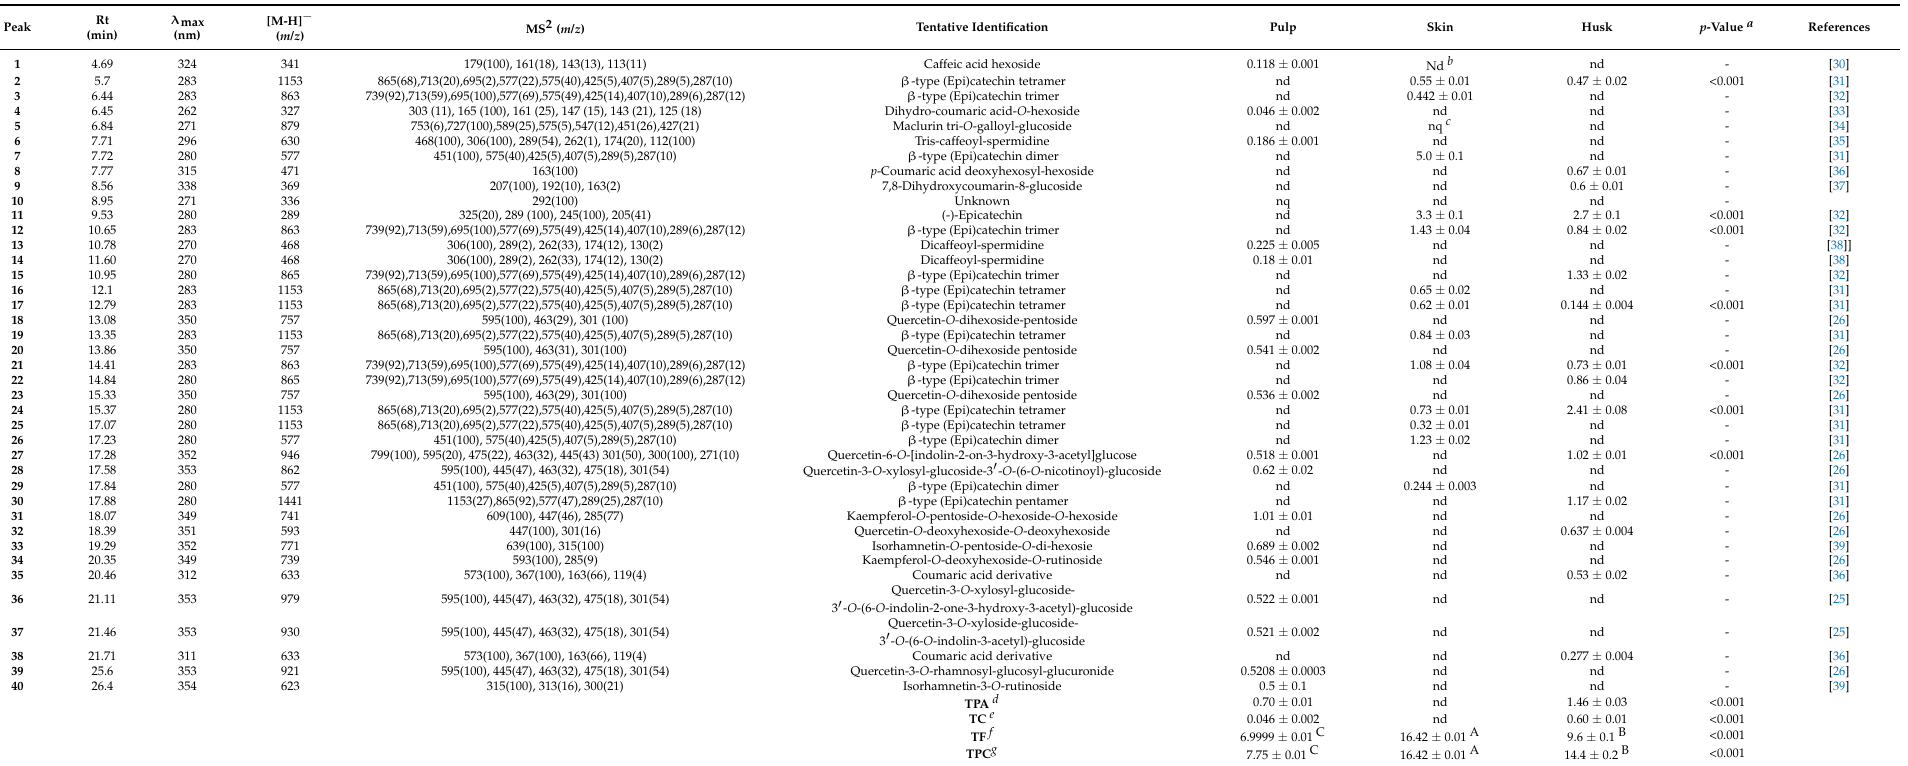
Table 2. Retention time (Rt), wavelengths of maximum absorption in the visible region ( λ max ), mass spectral data, tentative identification, and quantification (mg/g extract) of phenolic compounds in pulp, skin, and husk of Aesculus hippocastanum L.